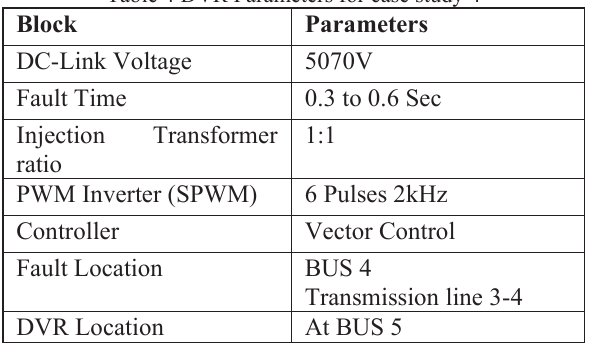
Table 4 DVR Parameters for case study 4